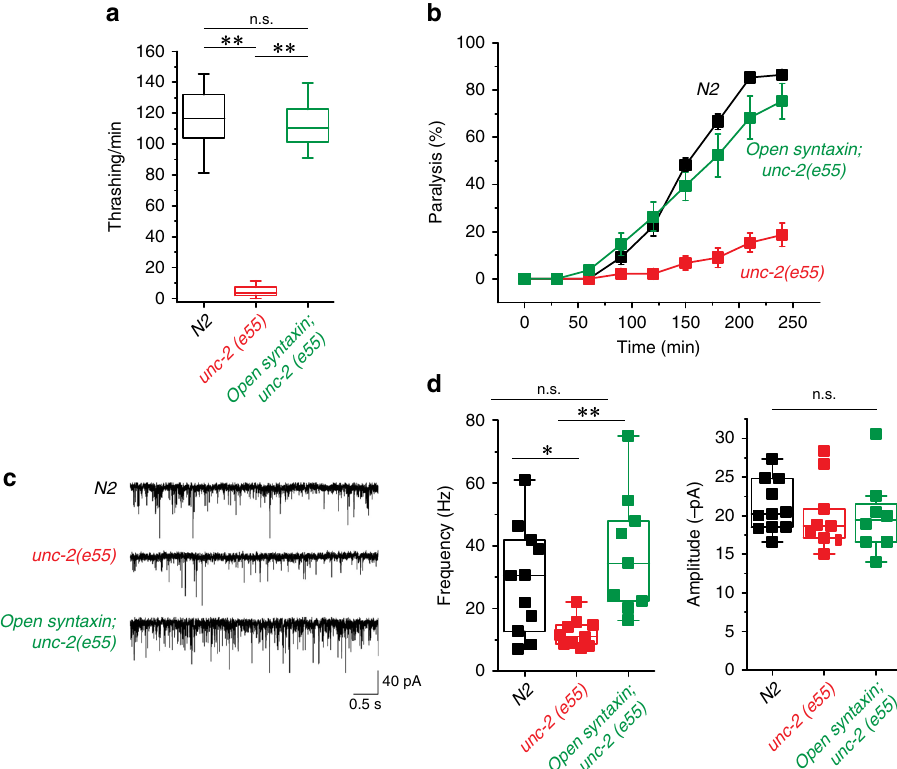
Fig. 4 The knock-in open syntaxin mutation rescues the behavioral and exocytosis defects of unc -2-null C. elegans . a Box-and-whisker plots of thrashing assay for N2, unc-2(e55) , and open syntaxin; unc-2(e55) double mutants in M9 buffer. unc-2(e55) worms displayed greatly reduced thrashing rates (5.43 thrashes/min), which was rescued by the introduction of open syntaxin in the double mutant. n = 40 for each strain. In one-way ANOVA statistical tests, F (2,117) = 836 and p = 0.00. Tukey ’ s test was performed for means analysis in ANOVA. N2 vs. unc-2(e55) : ** p = 0.00; unc-2(e55) vs. open syntaxin; unc-2 (e55) : ** p = 0.00, N2 vs. unc-2(e55) open syntaxin : n.s. p = 0.13. b Aldicarb assays of N2, unc-2(e55) , and open syntaxin; unc-2(e55) double mutants. unc-2 animals displayed resistance to aldicarb, while the double mutant restored aldicarb sensitivity to near wild-type levels. n = 6. Each assay was conducted with 15 – 20 worms. Error bars represent SEM. c Representative mPSC traces recorded from N2, unc-2(e55) , and open syntaxin; unc-2(e55) worms. d Box- and-whisker plots overlaid with the corresponding data points (squares) of mPSC frequency (left) and amplitude (right) of N2, unc-2(e55) , and open syntaxin; unc-2(e55) worms. In one-way ANOVA tests, there was a signi fi cant difference among groups in frequency [ F (2,27) = 7.01 and p = 0.00]. Tukey ’ s test was performed for means analysis in ANOVA for amplitude. For N2 vs. unc-2(e55) : * p = 0.046; for unc-2(e55) vs. open syntaxin; unc-55(e55) : ** p = 0.003; for N2 vs. open syntaxin; unc-2(e55) : n.s. p = 0.41. There was no signi fi cant difference among groups in amplitude [ F (2,27) = 0.23 and p = 0.79]. n = 11 for N2, n = 10 for unc-2(e55) and n = 9 for open syntaxin; unc-2(e55) animals. Box-and-whisker plots represent the median (central line), 25th – 75th percentile (bounds of the box), and 5th – 95th percentile